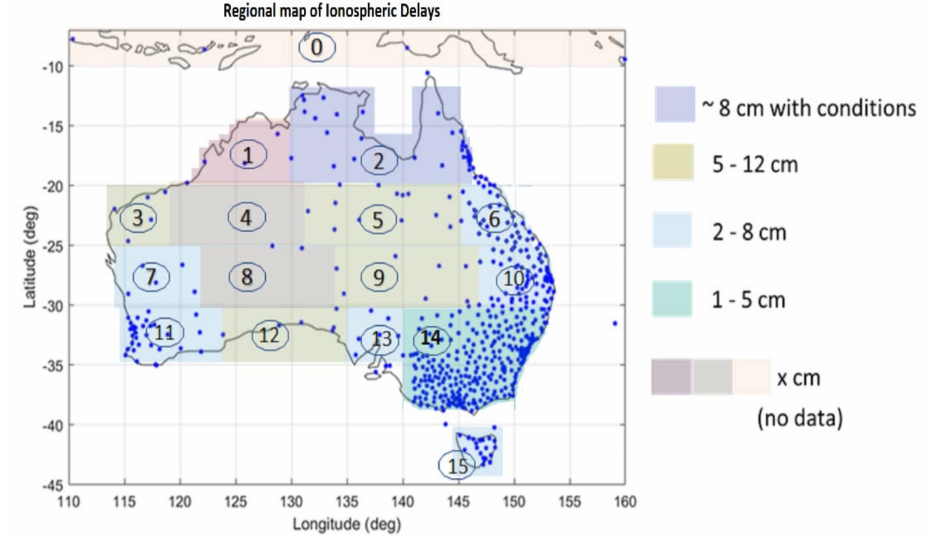
Figure 15. A map showing the recommended regions for mapping of the SD ionospheric corrections and the achievable accuracy using a simple linear interpolation method. The blue dots represent CORS stations in our testing. The labels of 1 to 15 describe 15 regional maps that are divided based on the available testing